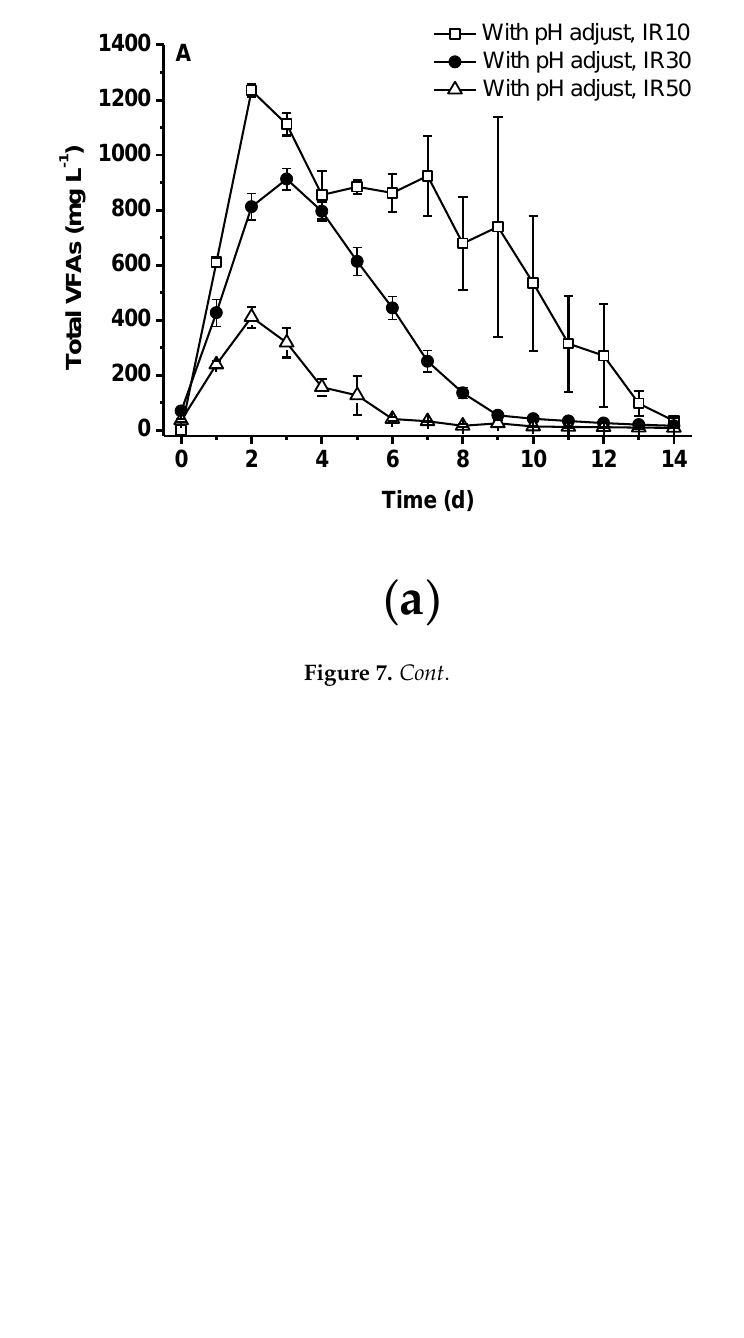
( b ) Figure 6. Effect of different IR (without pH adjustment) on total VFAs ( a ) and propionic acid concentrations ( b ). Data indicate mean and its standard deviation of triplicates. 3.6. Effect of IR on VFAs Concentration for the Groups with pH Adjustment The results showed that the groups with lower inoculation ratios accumulated more VFAs than the groups with higher inoculation ratios (Figure 7a). The highest total VFAs peaks were on days 2 and 3 for the groups of IR 10 (1234 ± 23 mg/L), IR 30 (913 ± 38 mg/L), and IR 50 (412 ± 38 mg/L), respectively (Figure 7a). These results indicate that the groups with higher inoculation ratios consumed VFAs at a higher rate. According to the study of Ward et al. (2008), rapid VFAs accumulation is an indicator for an overload of the organic loading rate [35]. The group, IR 10 , showed the highest total VFAs accumulation and lowest cumulative biogas yield compared to the groups, IR 30 and IR 50 . It indicated that there was